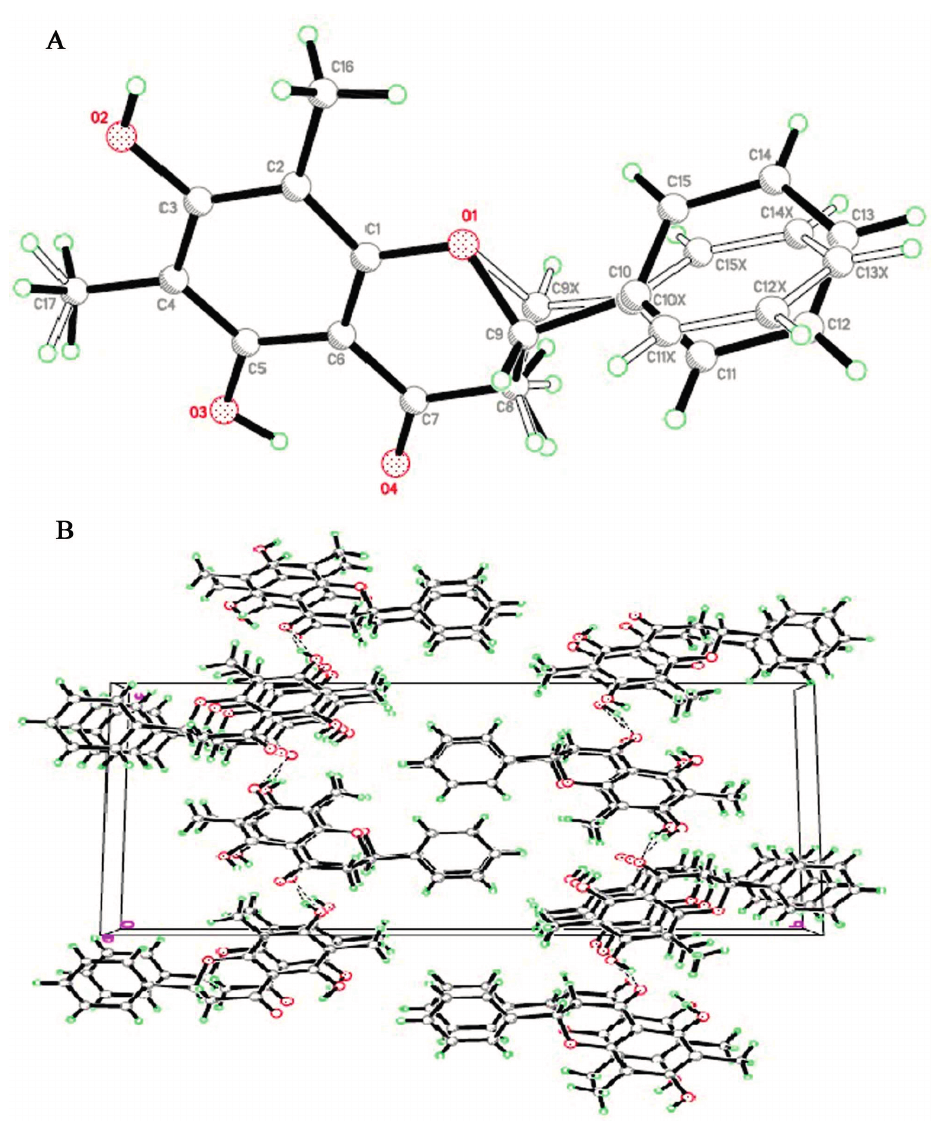
Figure 7. ( A ) Stereochemical structures of ( S )-5,7-dihydroxy-6,8-dimethyl flavanone; ( B ) Crystal packing of ( S )-5,7-dihydroxy-6,8-dimethyl flavanone. The molecules packed in monoclinic crystal system through intermolecular hydrogen bonds shown as dashed lines. Table 1. Crystal data and structure refinement details for (2 S